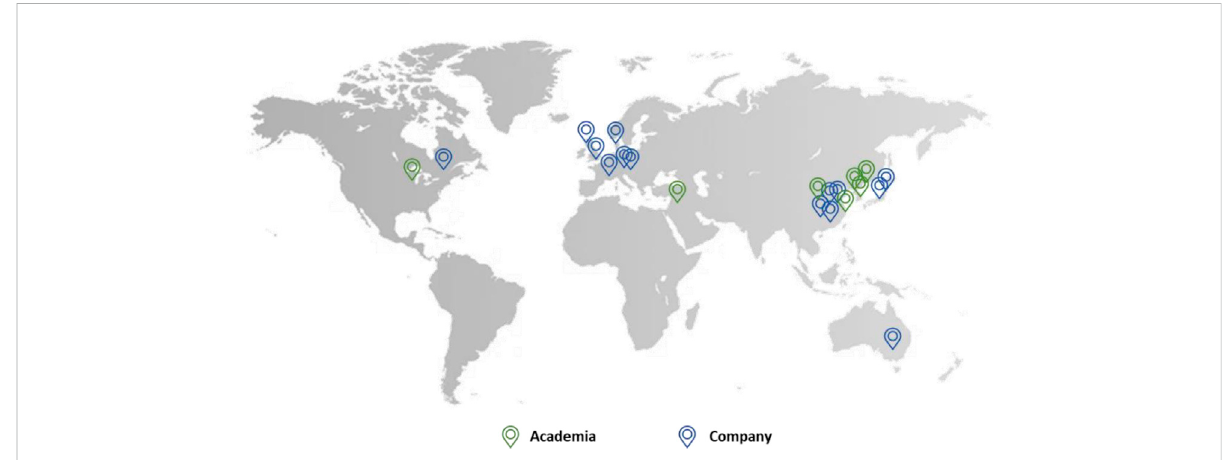
FIGURE 11 The location of academia (green) and companies (blue) which patented urea-based anticancer drugs